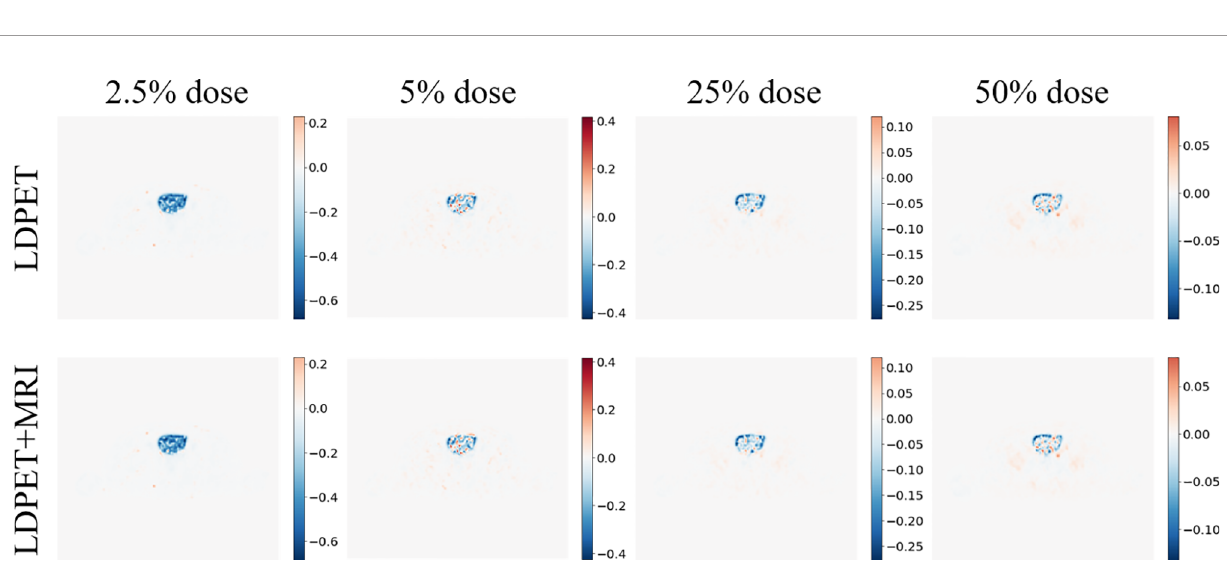
FIGURE 4 | Synthesized FDPET image, MR prior for all doses, combined FDPET image and target subtraction difference map and original